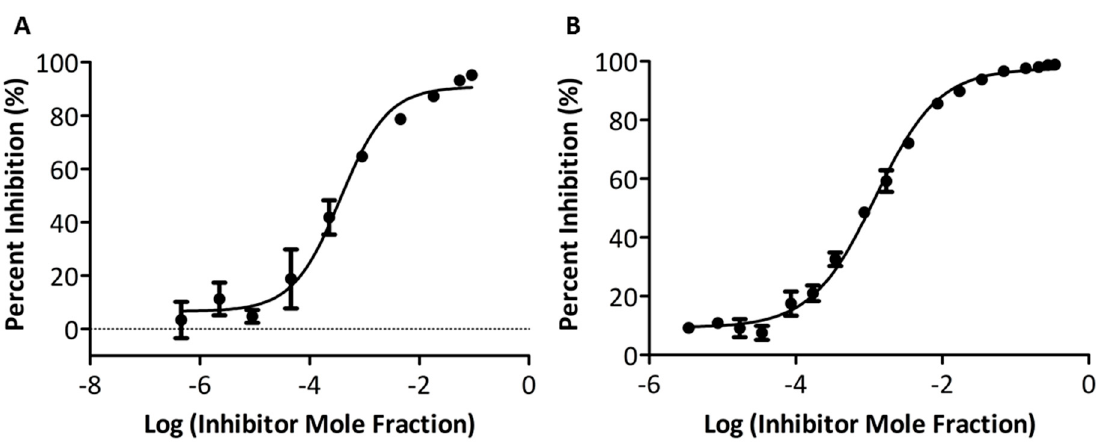
Figure 4. Dose-response inhibition curves for GIVA cPLA 2 inhibitors GK587 ( A ) and GK639 ( B ). The curves were generated using GraphPad Prism version 5.04 (GraphPad Software Inc., San Diego CA, USA) with a nonlinear regression targeted at symmetrical sigmoidal curves based on plots of % inhibition vs. log(inhibitor mole fraction). The reported X I (50) values were calculated from the resultant plots.